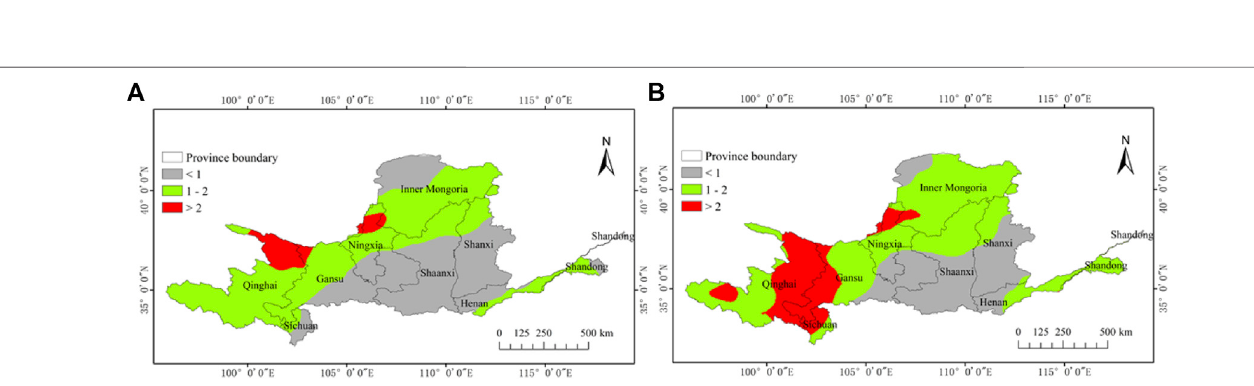
FIGURE 15 | Signal-to-noise ratios of the future projected precipitation based on the grid-based BMA in the future period of 2021 – 2050 (A) and 2061 – 2090 (B) .